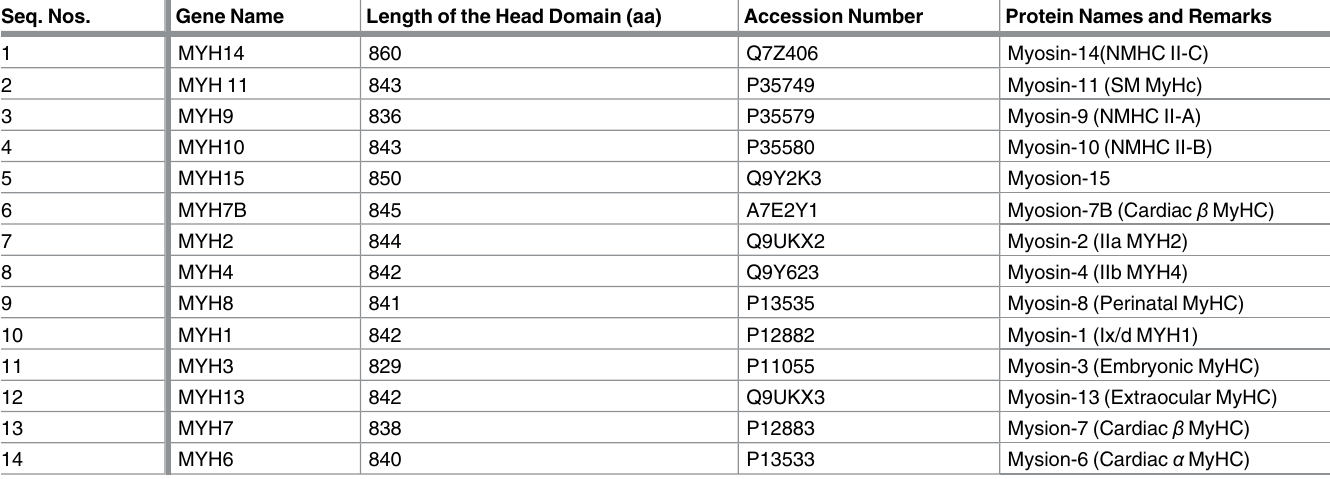
Table 3. Details of conventional myosin II family membersin human. Seq. Nos.